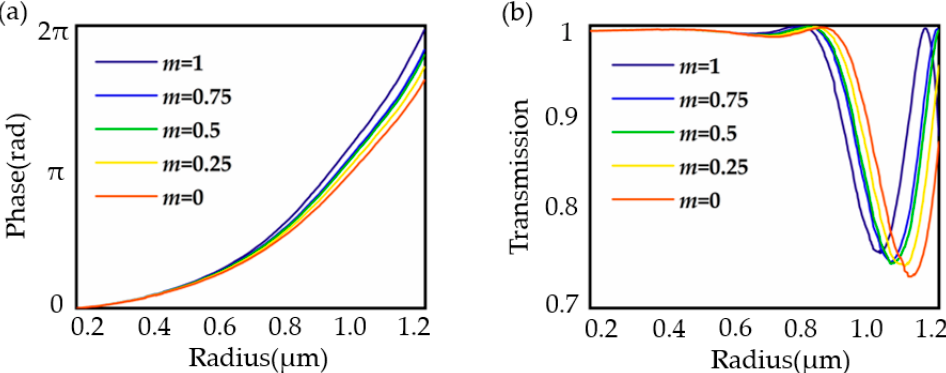
Figure 4. The optical response of the GSSe cylindrical nanopillars with different crystallization fractions m. The phase shifts ( a ) and transmission amplitudes ( b ) of the GSSe nanopillars with crystalline fraction m from 1 to 0 as a function of the nanopillars’ radius.